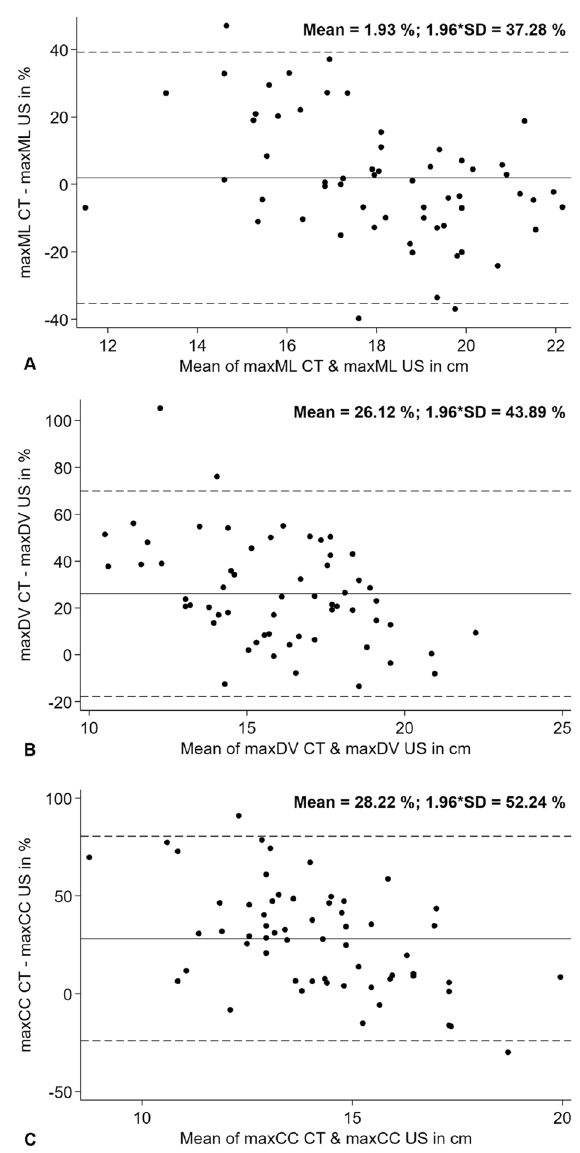
Figure 4. Bland–Altman correlation between the diameters measured in maximum extension in ultrasound and CT ( A ) in mediolateral, ( B ) dorsoventral and ( C ) craniocaudal orientation with showing the smallest difference in mediolateral extension.